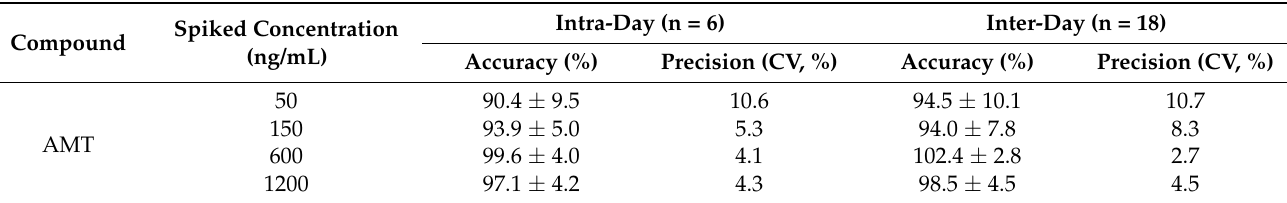
Table 2. Precision and accuracy for AMT in human plasma.